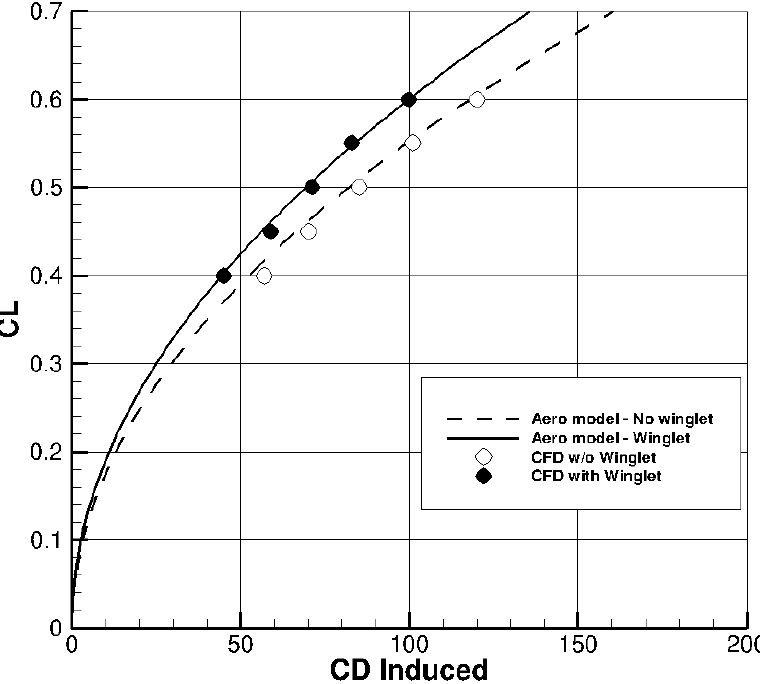
Figure 15. NOVA configuration—winglet effect ( δ WLT = − 18°). Lines—aerodynamic module; symbols—CFD.